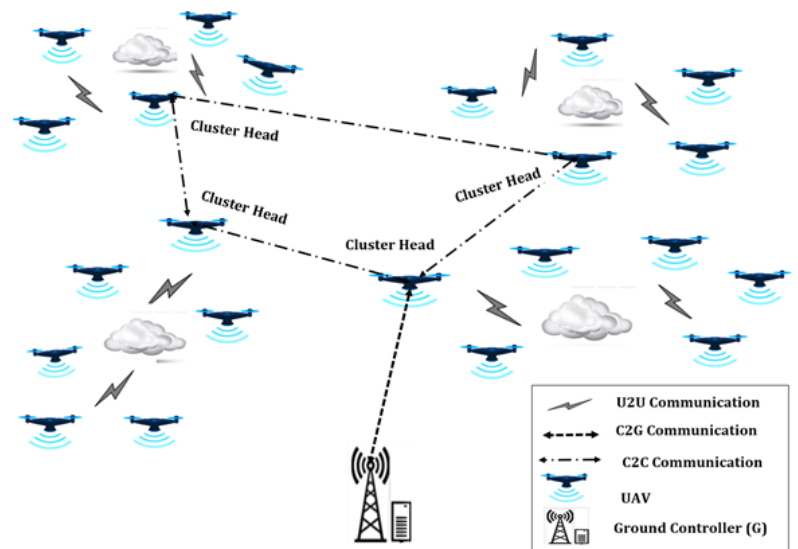
Figure 3. Cluster-based ad hoc interactive